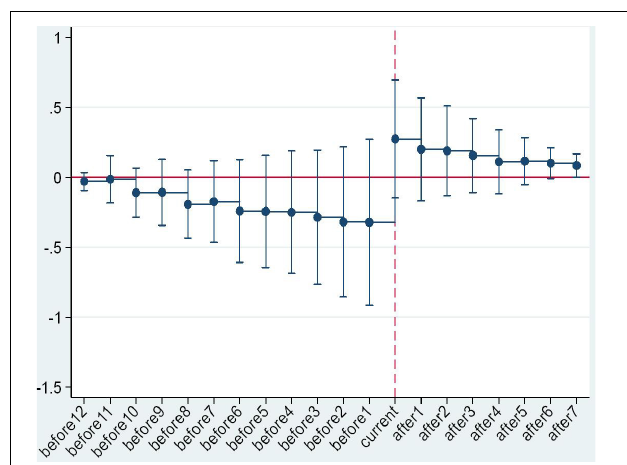
FIGURE 3 | Parallel trend test in the eastern region.